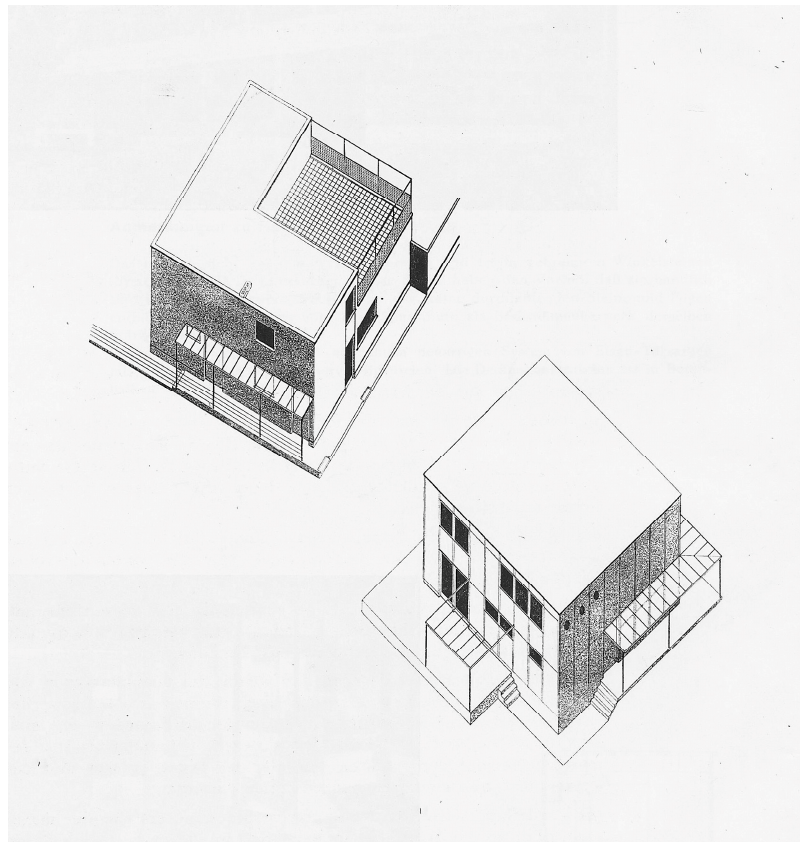
Figure 11. Walter Gropius: Experimental houses number 16 and 17 at the Stuttgart Werkbund exhibition Am Weißenhof, 1926–1927—Isometric drawing. Image from (Gropius 1927a, p. 58).